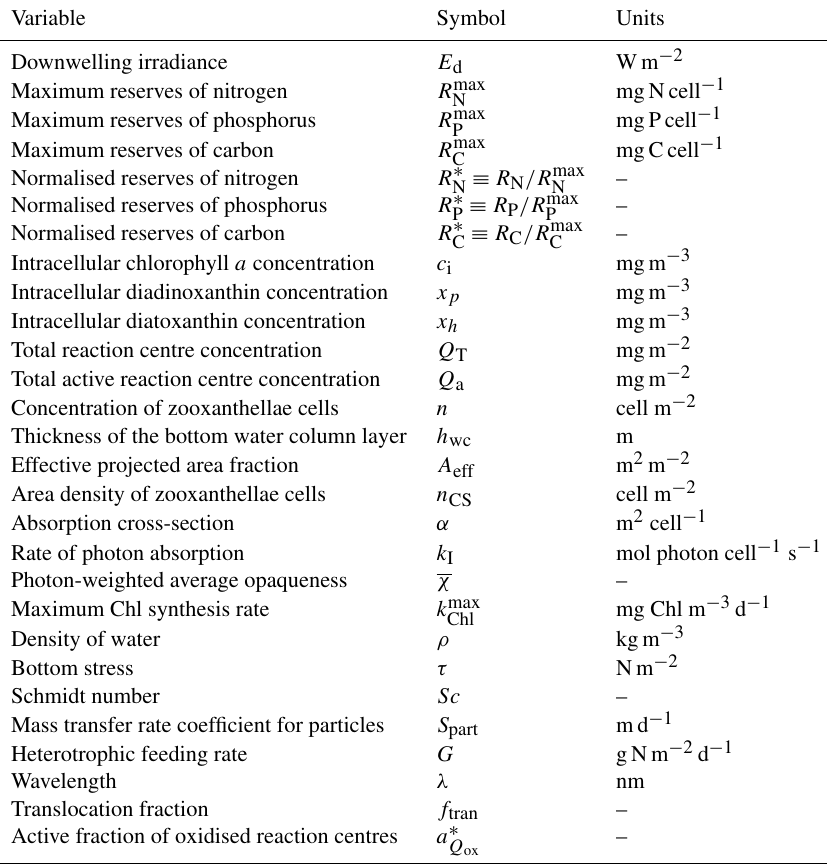
Table 25. Derived variables for the coral polyp model. Variable Symbol Downwelling